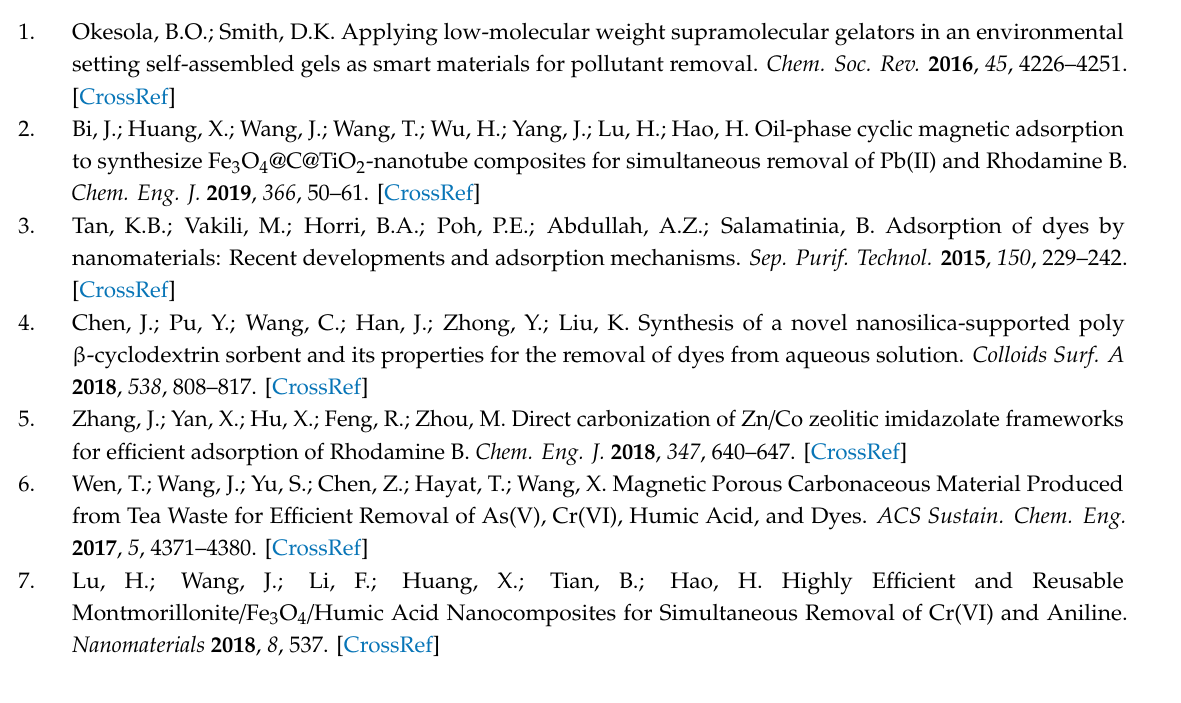
Figure S1: TG curve of the as-prepared WS 2 ; Table S1: Kinetic parameters of the WSO-n, WS 2 , WO 3